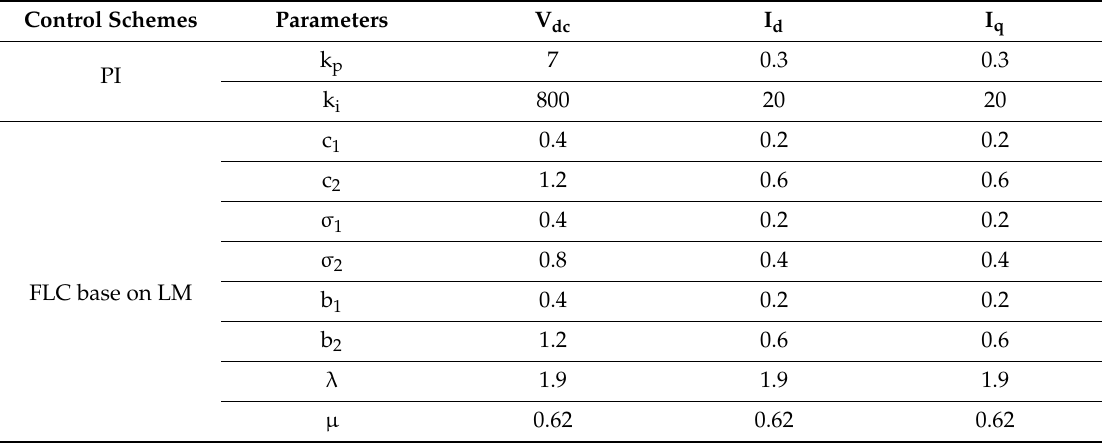
Table A2. Control scheme